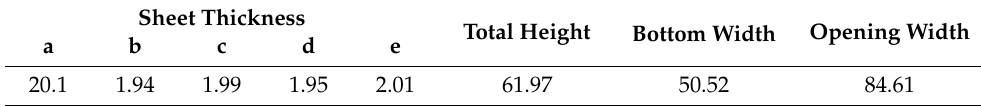
Figure 11. OM images at the bottom ( a , b ) and sidewall ( c , d ) of the U-shaped part.